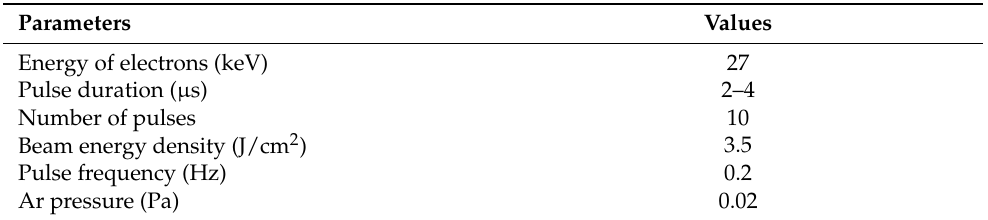
Table 1. EB operating conditions for pretreatment of the samples.